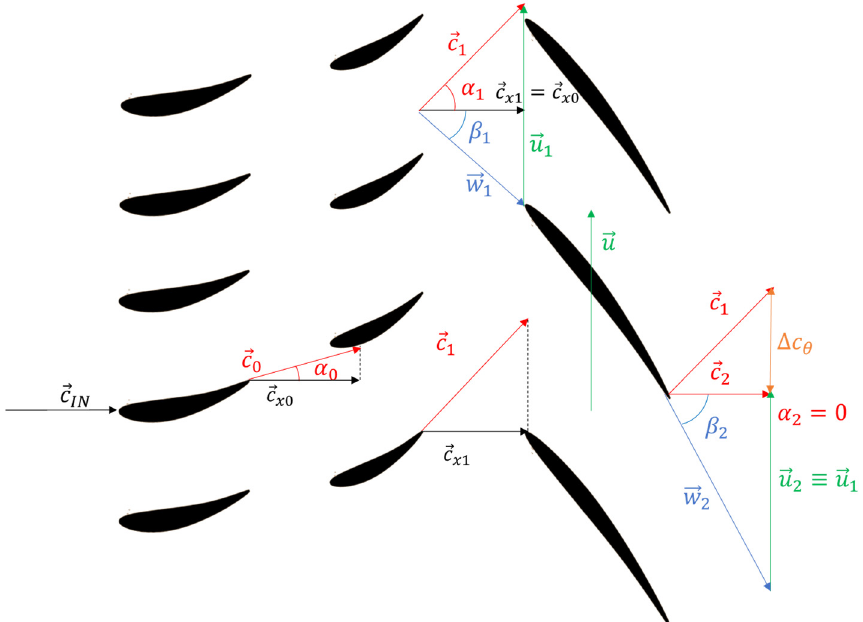
Figure 3. Guide vane and rotor blade profiles in the meanline blade-to-blade plane and flow velocity triangles at the design condition.